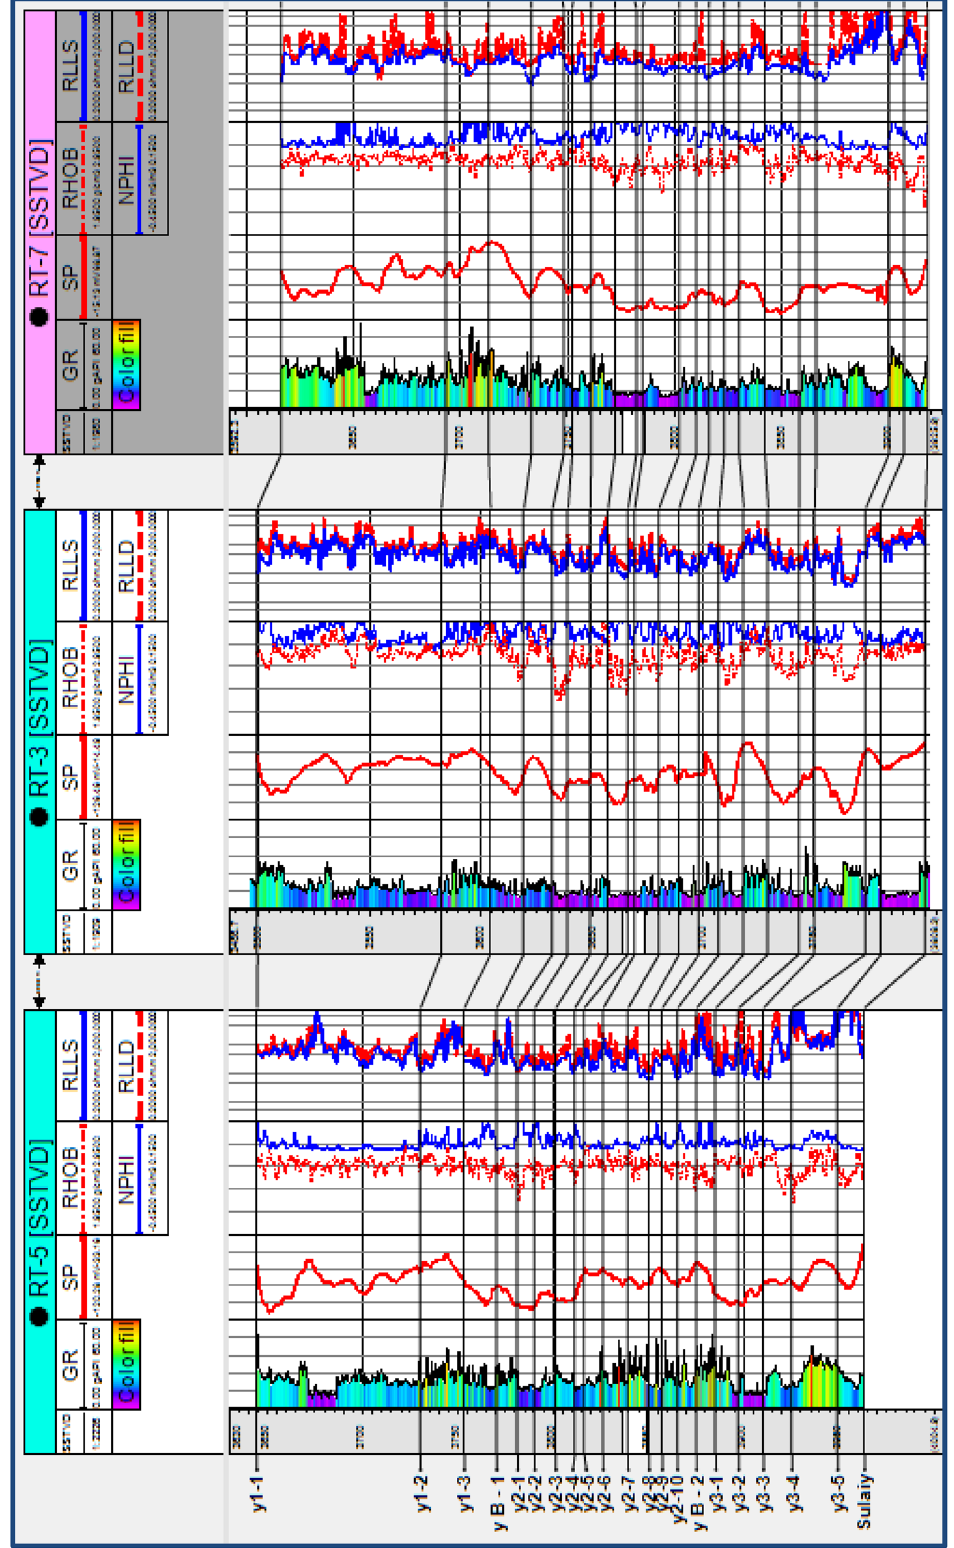
Fig. 5 Well logs section for wells Rt-5, 3, and 7 in Yamama